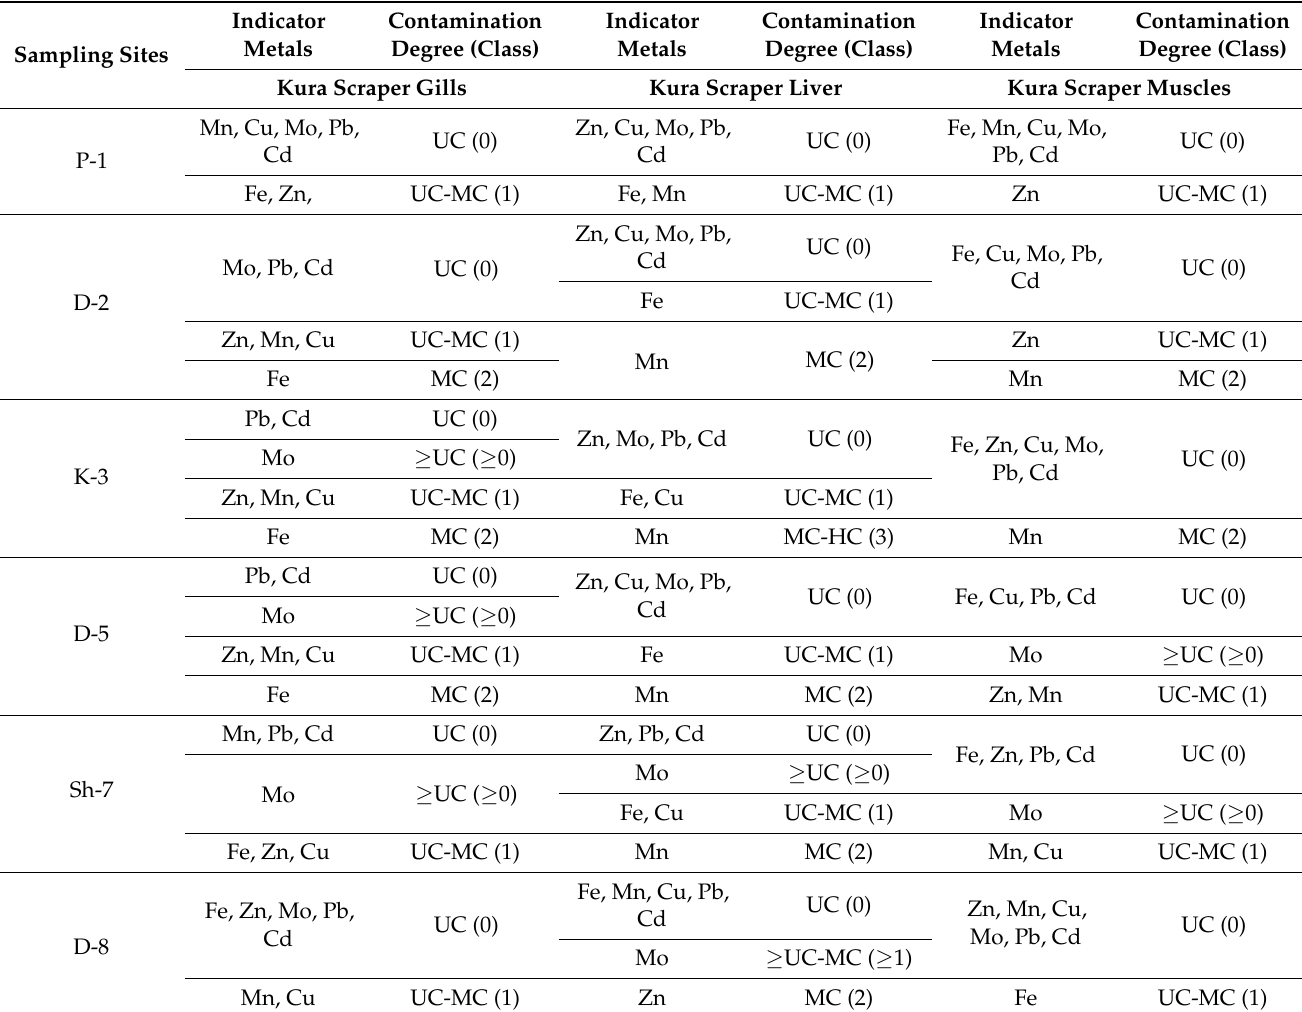
Table 7. HM contamination degrees in the river fish of the Debed catchment